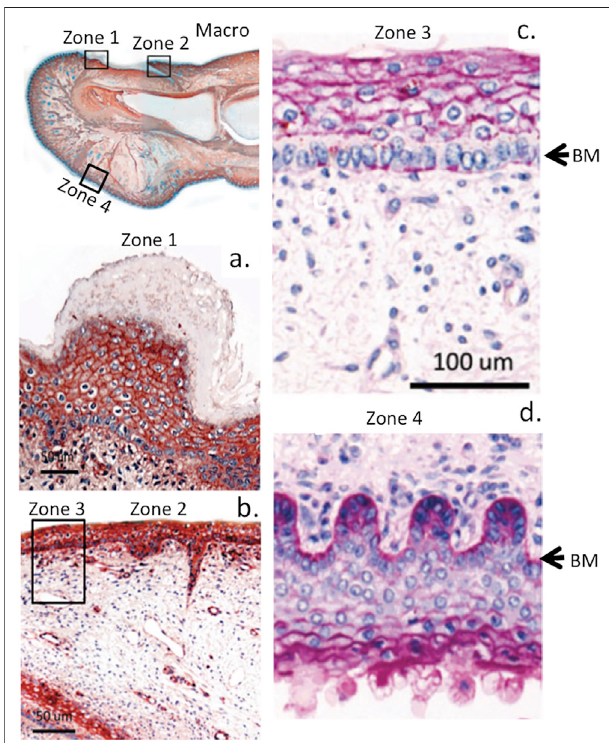
FIGURE4| Immunolocalisationofperlecanina14-weekgestationalage human hallux (big toe). Top left panel shows a macroscopic view with boxed regionsdepictedathighermagni fi cationinsubjacentpanels (A,B) .Right-hand panel shows periodic acid-schiff (PAS) staining of the foetal hallux showing selected regions of its anterior and posterior surfaces. The strong reaction (purple staining) indicates the presence of perlecan HS and other matrix polysaccharides (e.g., hyaluronic acid, HA) within the basement membrane(BM)andepidermis (C,D) ofthedigit.Imagesmodi fi edfrom(Smith and Melrose, 2015) with permission. Images © the authors